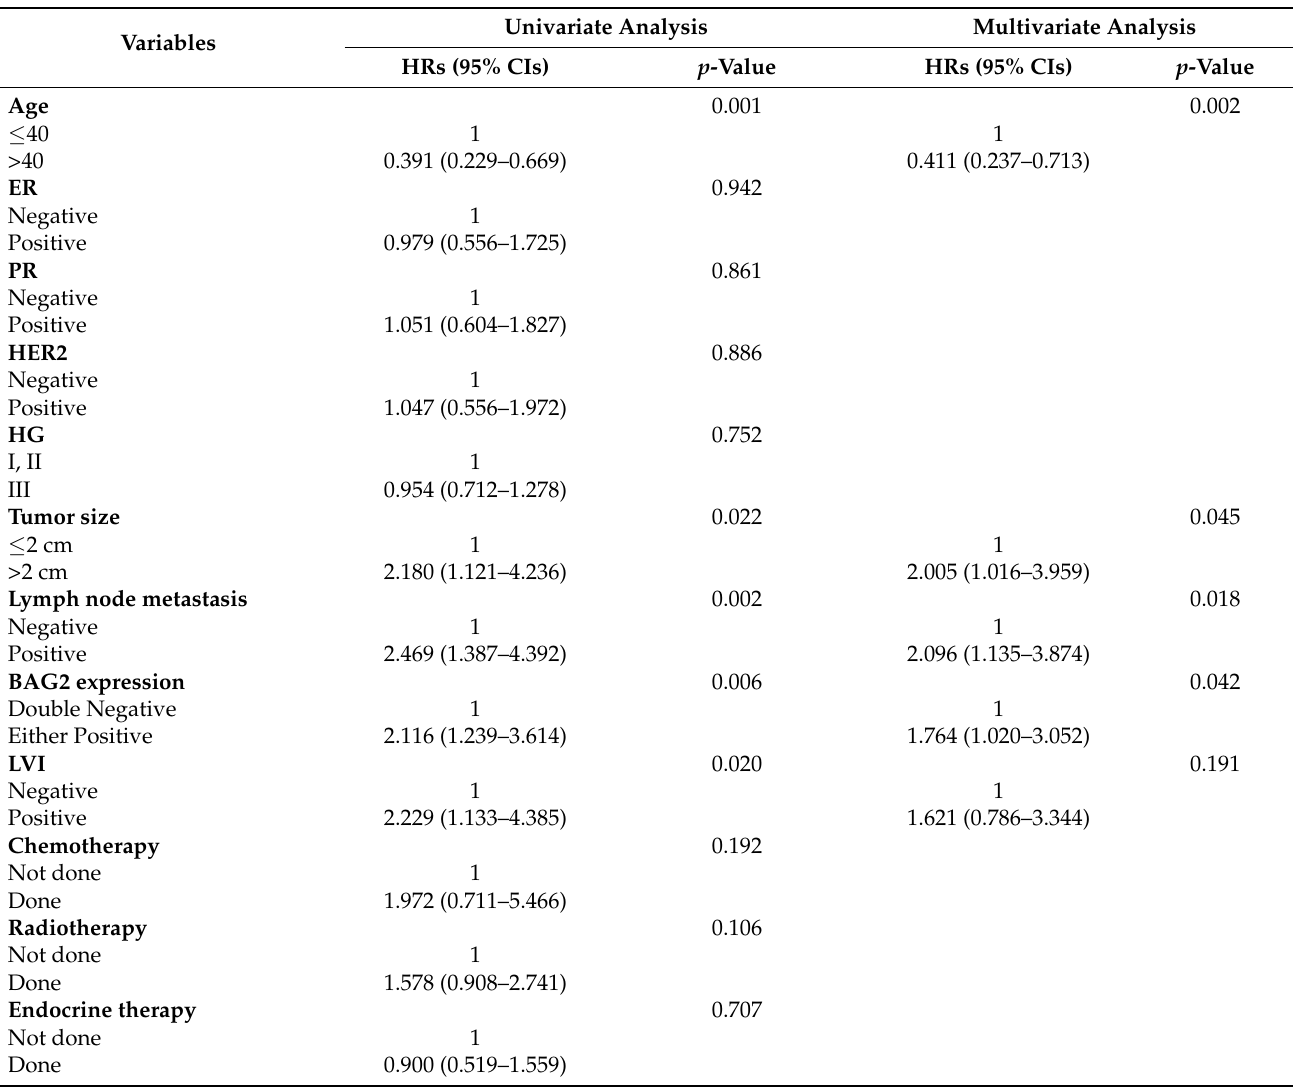
Table 4. HRs and 95% CIs for DMFS at BAG2 expression in cytoplasm and CAF.